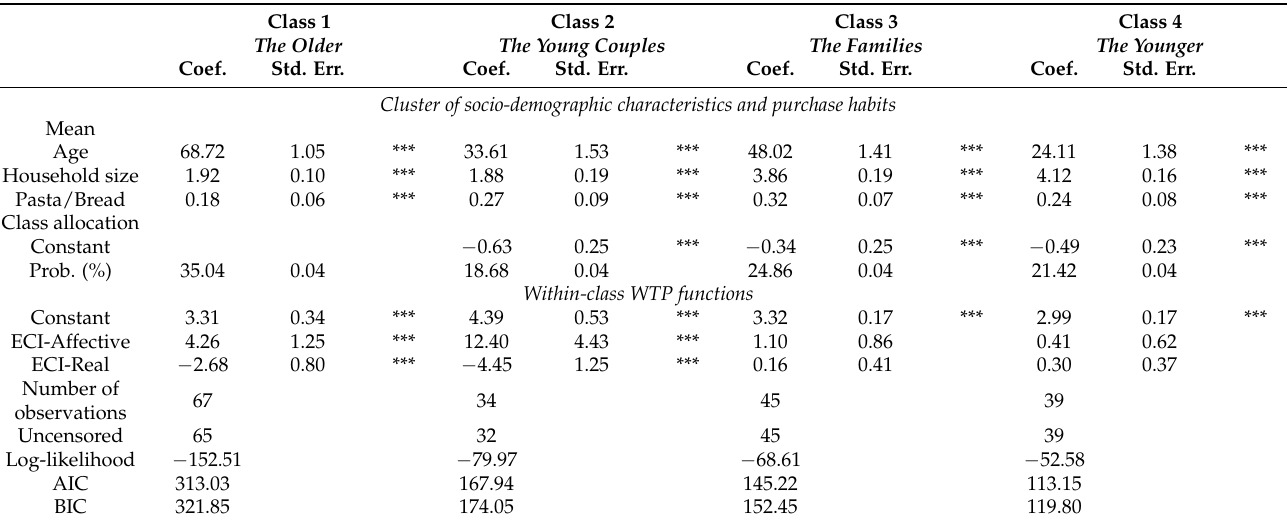
Table 4. Drivers of WTP. LCC analysis and within-class WTP functions (Tobit